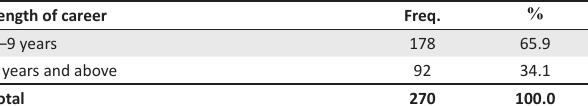
TABLE 1d: Background of respondents.